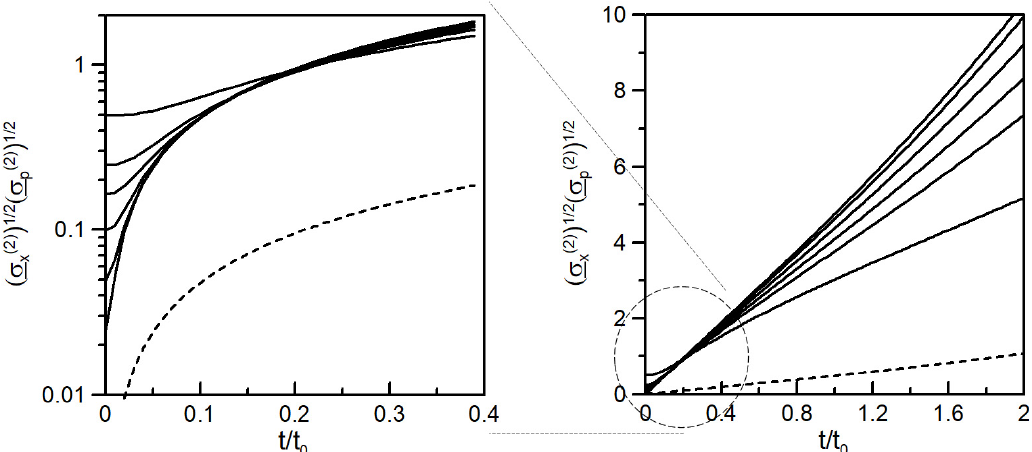
( 2 ) ( τ )) 1/2 ( σ ( 2 ) ( τ )) 1/2 for the liquid case ( α = 10) are x p A